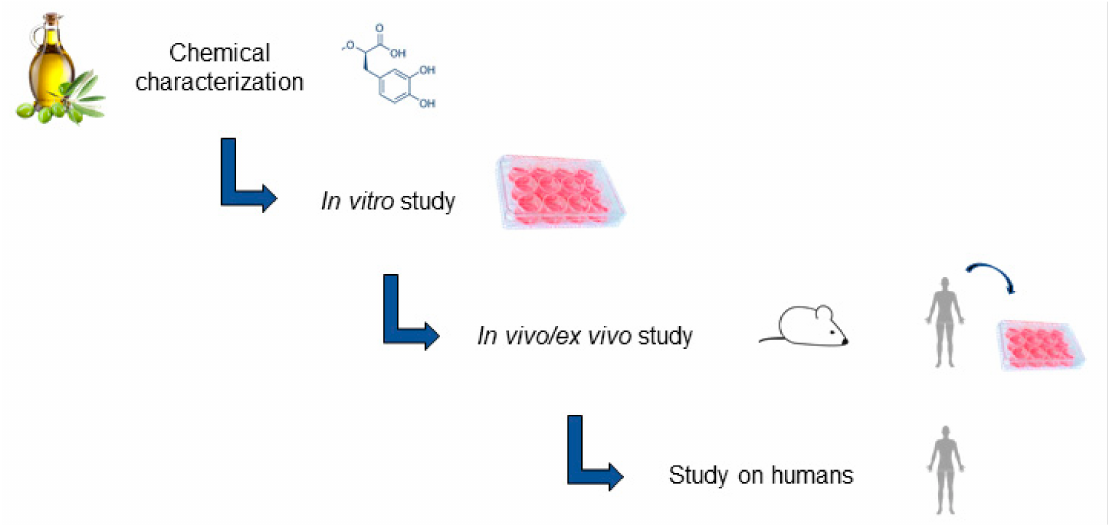
Figure 1. Systematic approach to study the EVOO beneficial activity on human